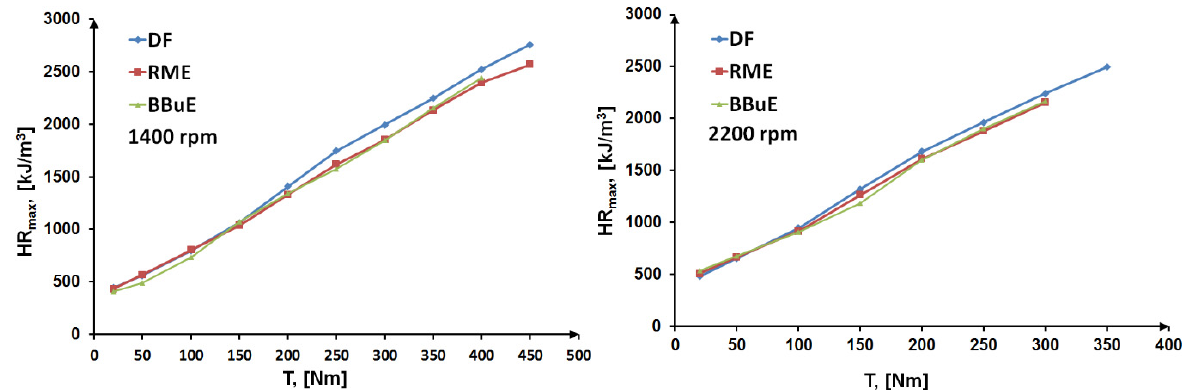
Figure 11. Maximum values of the amount of heat release HRmax during the combustion process.